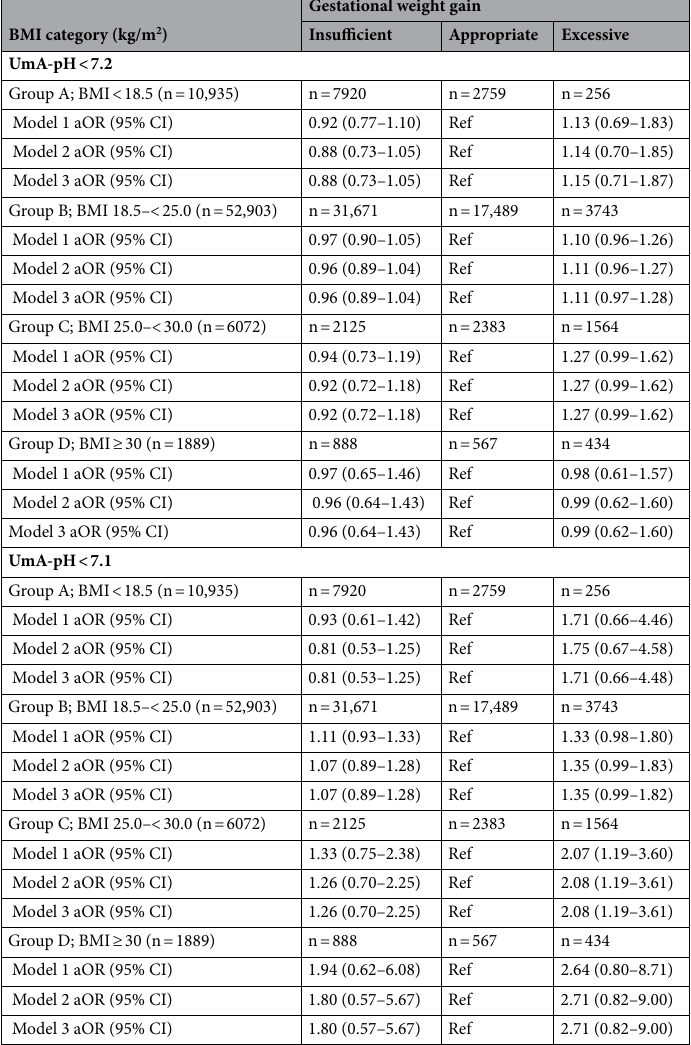
Table 2. Adjusted odds ratios a and 95% confidence intervals for foetal acidosis based on gestational weight gain described in the 2009 IOM guidelines. Logistic regression models were used to calculate the adjusted odds ratios and 95% confidence intervals for UmA-pH < 7.20, with women with appropriate gestational weight gain as the reference. BMI body mass index, IOM Institute of Medicine, UmA-pH umbilical artery pH. a Model 1 adjusted for maternal age, maternal education, annual household income, maternal smoking during pregnancy, and parity. Model 2 adjusted for covariates in Model 1 and preterm birth and small-for-gestational age infants. Model 3 adjusted for covariates in Model 2 and mode of